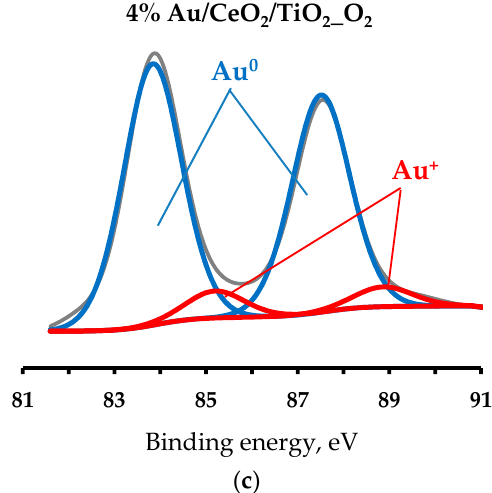
Figure A1. Au4f XP spectra of Au/CeO 2 /TiO 2 samples with different gold content (0.5 or 4 wt.%) pretreated in H 2 or O 2 flow at 300 °C for 1 h: 0.5%Au/CeO 2 /TiO 2 _O 2 ( a ), 0.5%Au/CeO 2 /TiO 2 _H 2 ( b ) and 4%Au/CeO 2 /TiO 2 _O 2 ( c ).